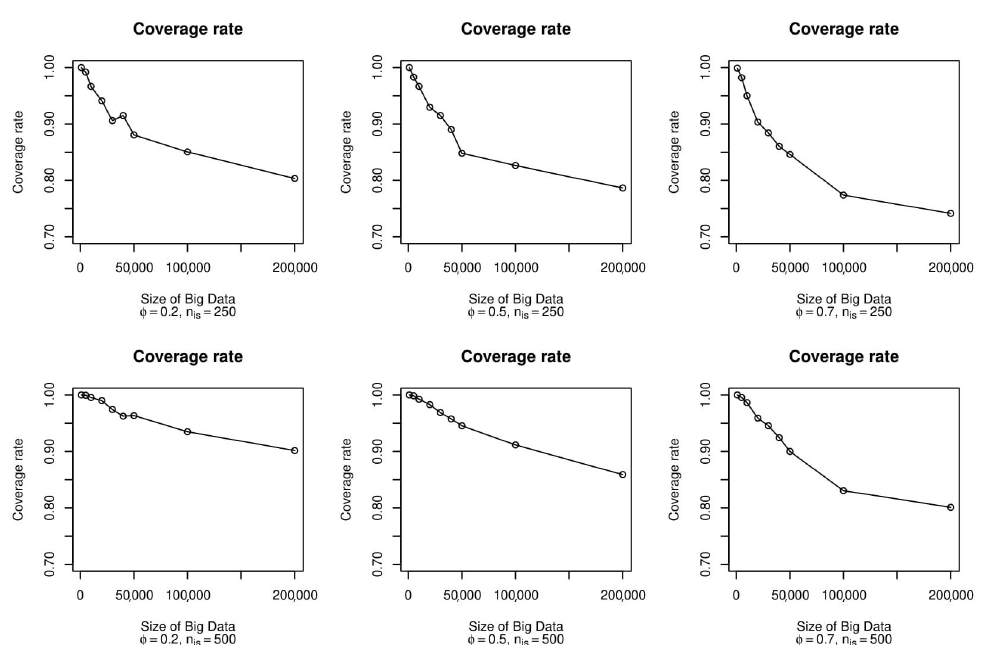
Figure 6. Coverage rate for the proportion parameter, according to the size of the big data, φ , and n is .